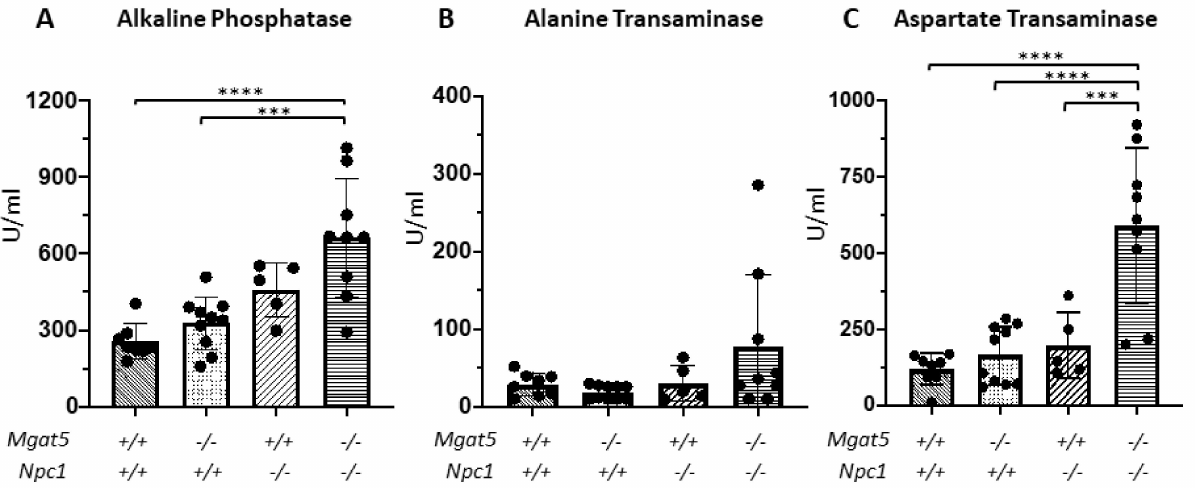
Figure 6. Serum alkaline phosphatase and transaminases. Levels of the liver enzymes, alkaline phosphatase ( A ), alanine transaminase ( B ), and aspartate transaminase ( C ) in the sera of 6-week-old mice were measured. Mgat5 +/+ :Npc1 +/+ (n = 8), Mgat5 − / − :Npc1 +/+ (n = 10), Mgat5 +/+ :Npc1 − / − (n = 5), and Mgat5 − / − :Npc1 − / − (n = 9). *** p < 0.001, **** p <